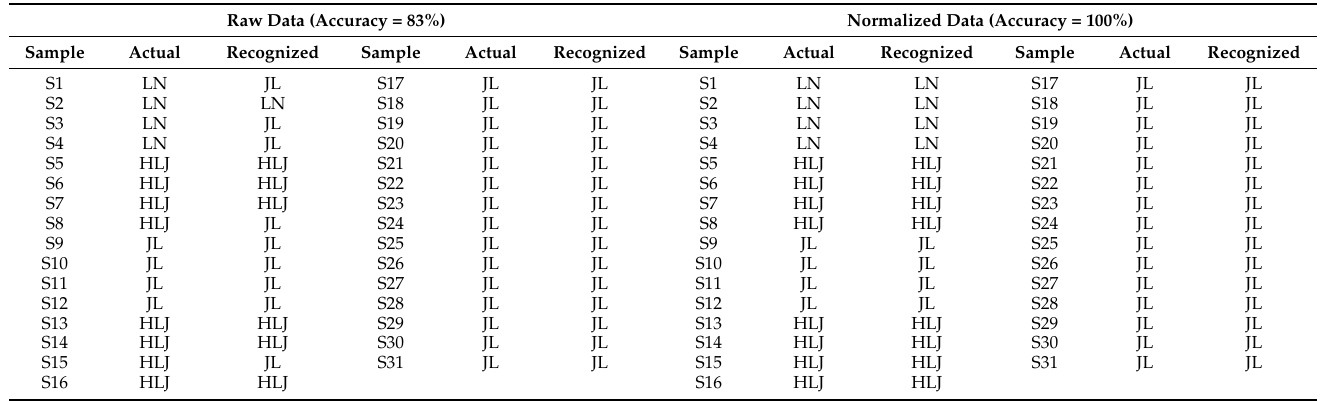
Table 2. The classified and predicted results of ginsengs from three geographical origins using SVM model with raw data and normalized data.